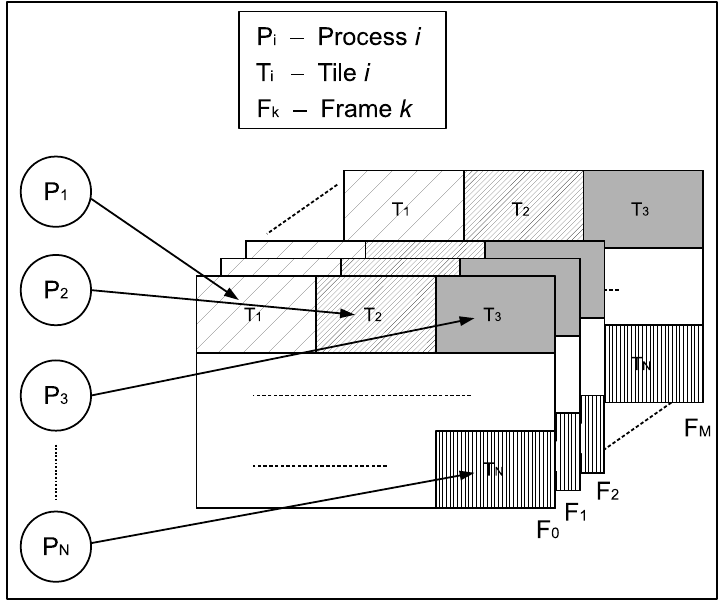
Figure 3. Tile-based parallel